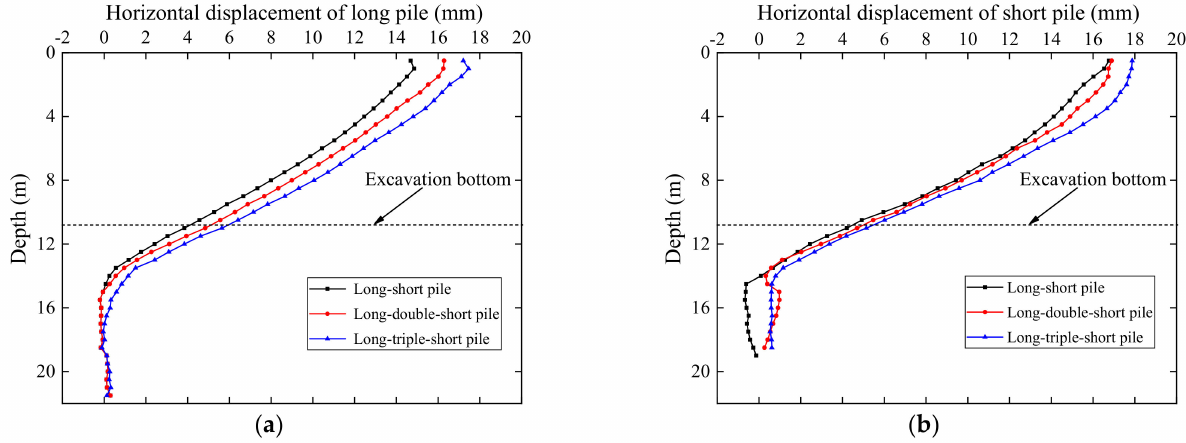
Figure 9. Horizontal displacement of long and short piles when excavated to the excavation bottom: